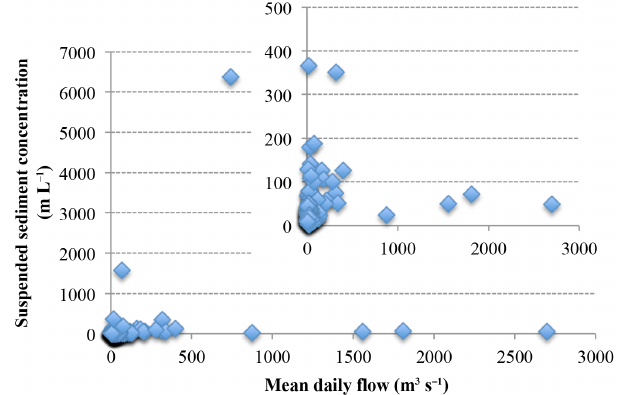
Figure 3. The Guadalquivir River basin in Spain draining to the Atlantic Ocean. Drainage network and reservoirs (dark blue small areas) upstream the estuary (grey area); the red point locates the Alcalá del Río dam, at the head of the estuary. The coloured sub- basins drain directly to the estuary area.